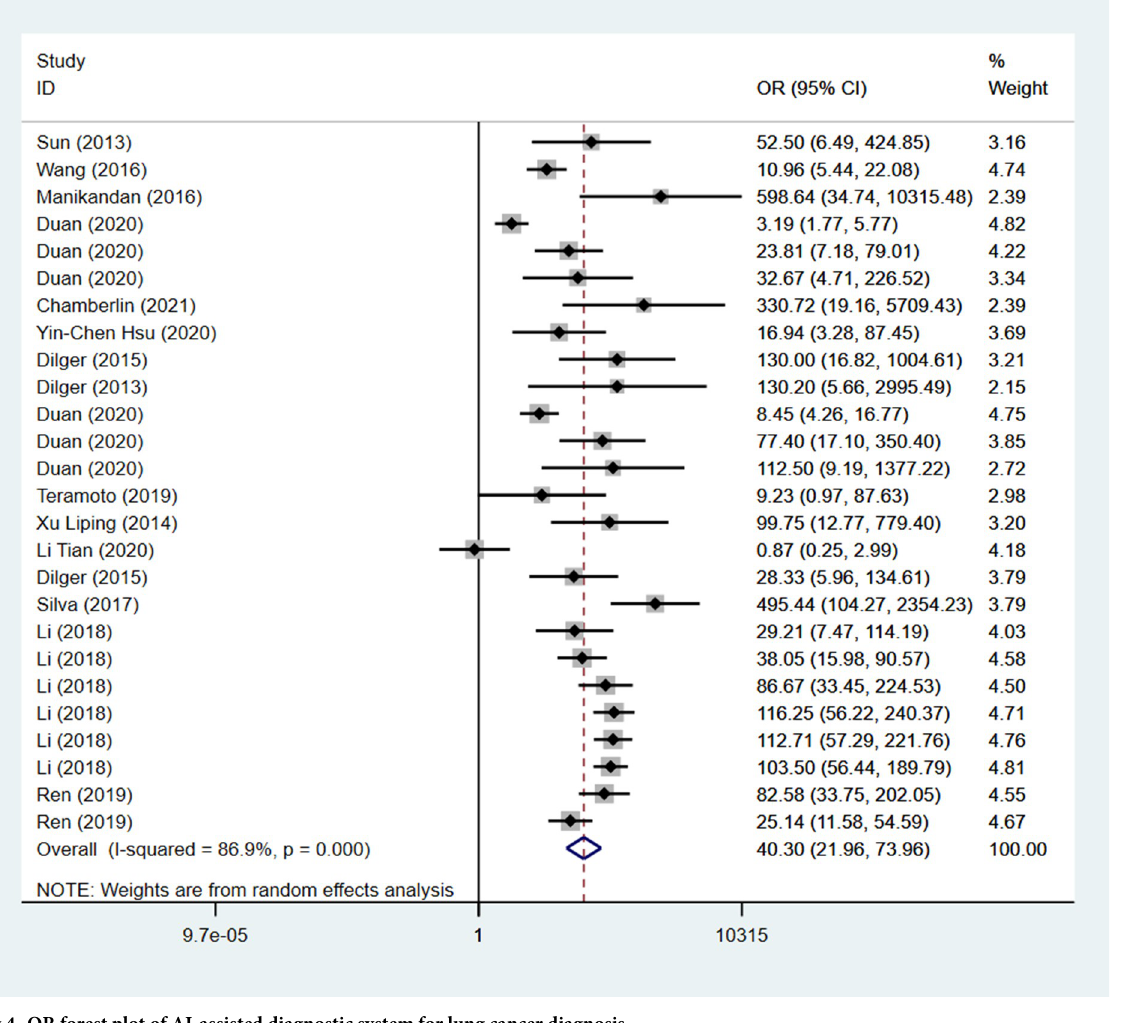
Fig 4. OR forest plot of AI-assisted diagnostic system for lung cancer